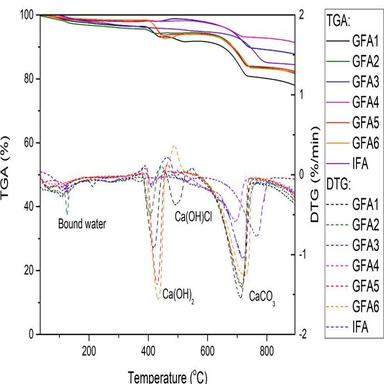
TGA and DTG curves of GFAs and IFAs.